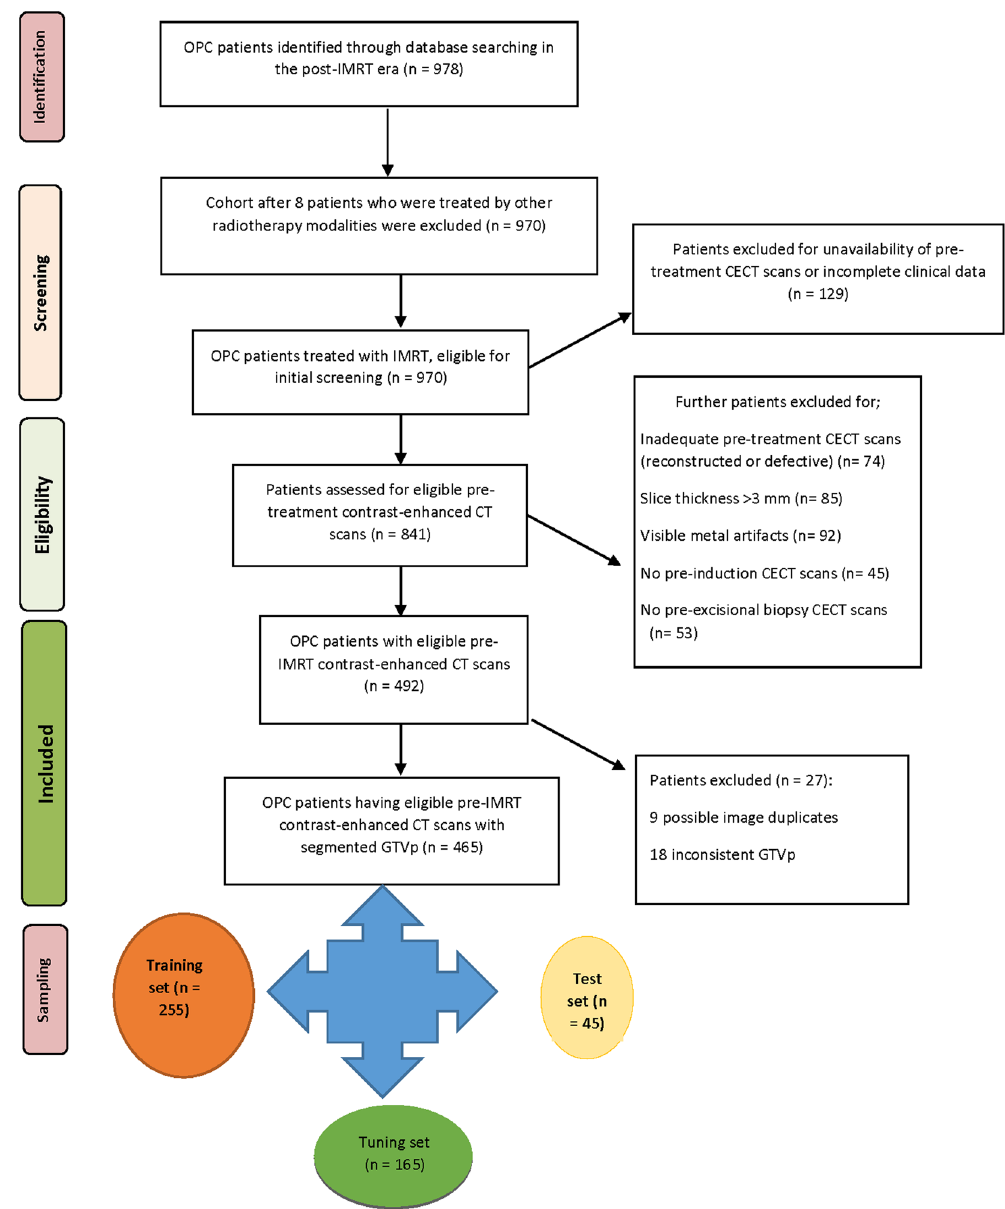
Figure 3. Flowchart of patient selection for